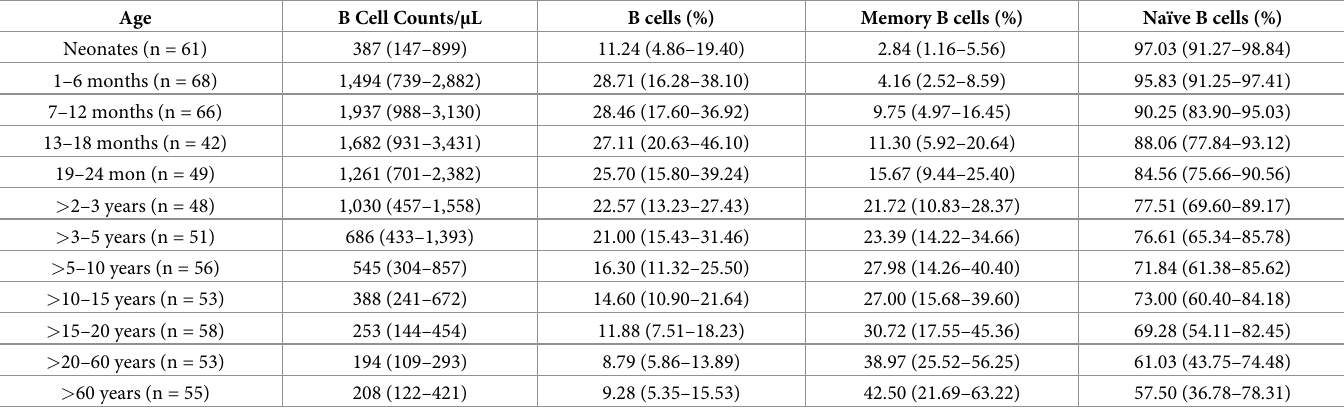
Table 2. Medians and 10 th and 90 th percentiles of absolute B cell counts per μ l of blood and for proportion of B cells, memory and na ï ve B cells in healthy partici- pants of different ages. Age B Cell Counts/ μ